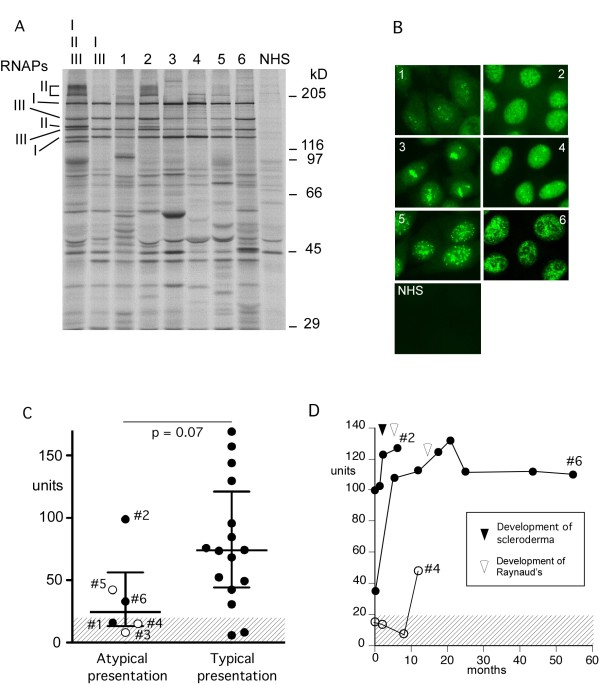
Anti-RNAP III antibodies by immunoprecipitation, immunofluorescence, and ELISA. A). Immunoprecipitation using 35S-methionine labeled K562 cell extract. 35S-methionine labeled K562 cell extract was immunoprecipitated by serum samples from patients with anti-RNA polymerase I/III, who had atypical clinical presentations (Table 1) and controls. RNAPs, RNA polymerases; I, II, III, two largest subunits of RNA polymerase I, II, and III, respectively; lane I, II, III, a reference serum with anti-RNAP I/II/III; lane I, III, a reference serum with anti-RNAP I/III; 1 to 6, IP with sera from cases 1 to 6; NHS, normal human serum; positions of molecular weight markers are also indicated. B). Immunofluorescence. HEp-2 ANA slide was stained with sera from cases 1 to 6 (Table 1) at 1:80 dilutions. C). Anti-RNAP III levels by ELISA. Sera from 21 cases with anti-RNAP I/III were tested by ELISA. Six cases of atypical presentation (Table 1) and 15 cases of typical presentation of SSc are shown. P = 0.04 by Mann-Whitney; closed circle, SSc; open circles, atypical cases in Table 1. D). Anti-RNAP III levels over time. Sera from cases 2, 4 and 6 over time were tested by anti-RNAP III ELISA. Time points of onset of sclerodermatous skin change (black arrowhead) or Raynaud's phenomenon (white arrowhead) are indicated. A cut-off (20 units) is shown as shaded area.